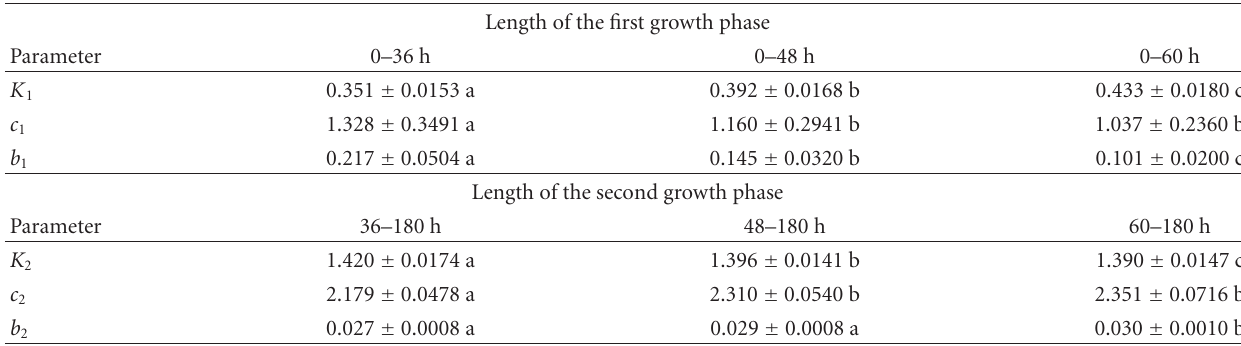
Table 1: Parameter values (means ± SD) of the Logistic equations (A.1) and (A.2) obtained by considering di ff erent time intervals for the first and second growth phases in the first realkalized fed-batch culture of Ent. faecium CECT 410 in whey.